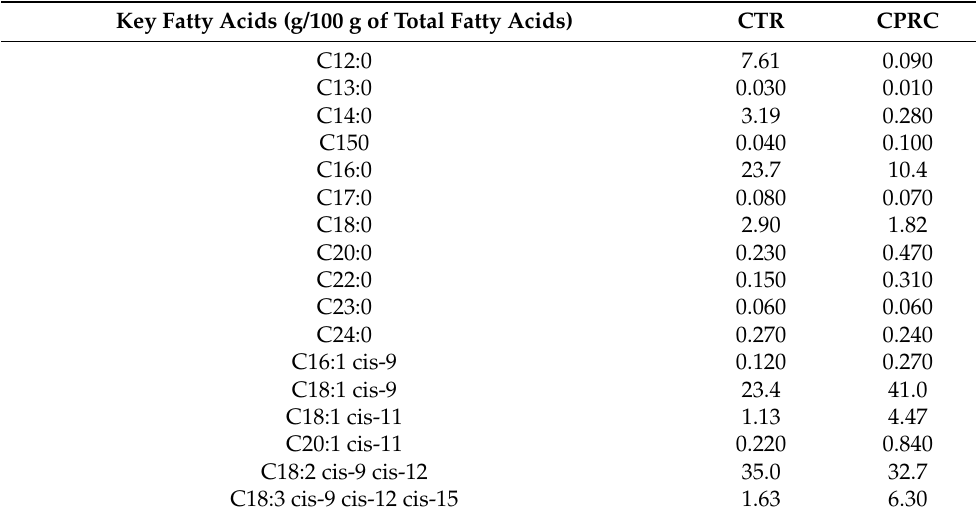
Table 2. Fatty acid composition of experimental concentrates. Key Fatty Acids (g/100 g of Total Fatty